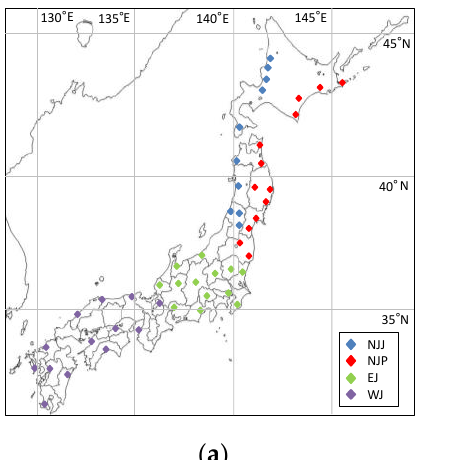
Figure 1. Spatial distribution of meteorological stations for each region of ( a ) the Japanese main- land and ( b ) the Southwestern Islands used for the classification of hot and cool summer years in this study.